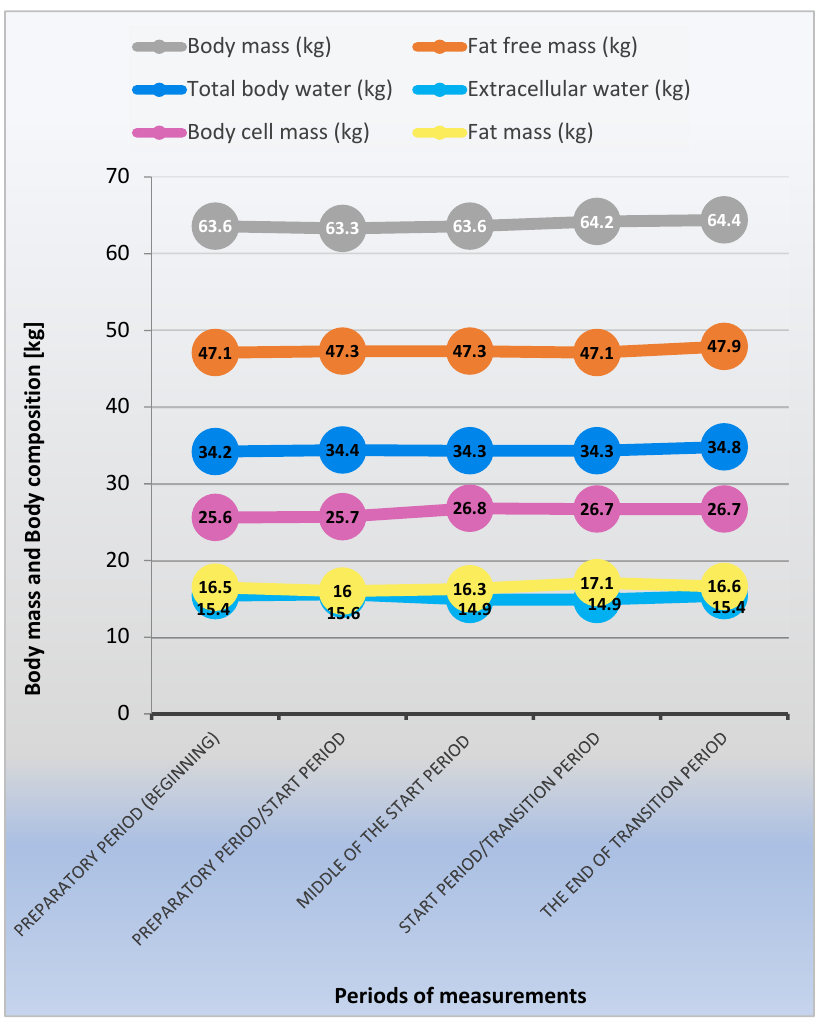
Figure 2. Changes in body composition in successive periods of measurements (1–5) during a mac- rocycle.